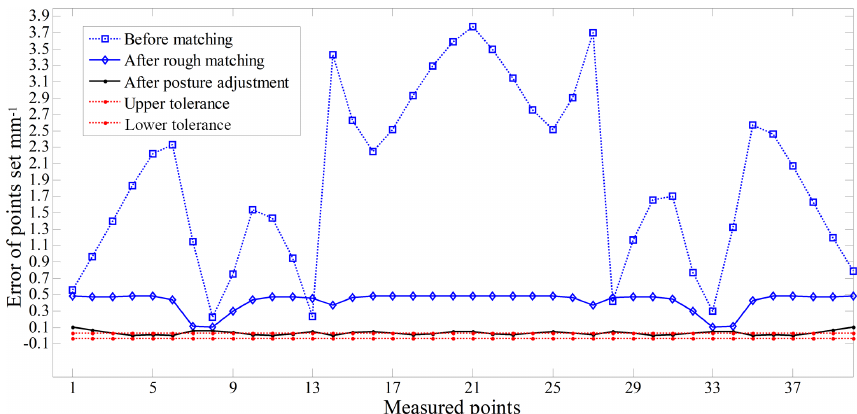
Figure 9. The errors of point set before and after posture adjustment by the